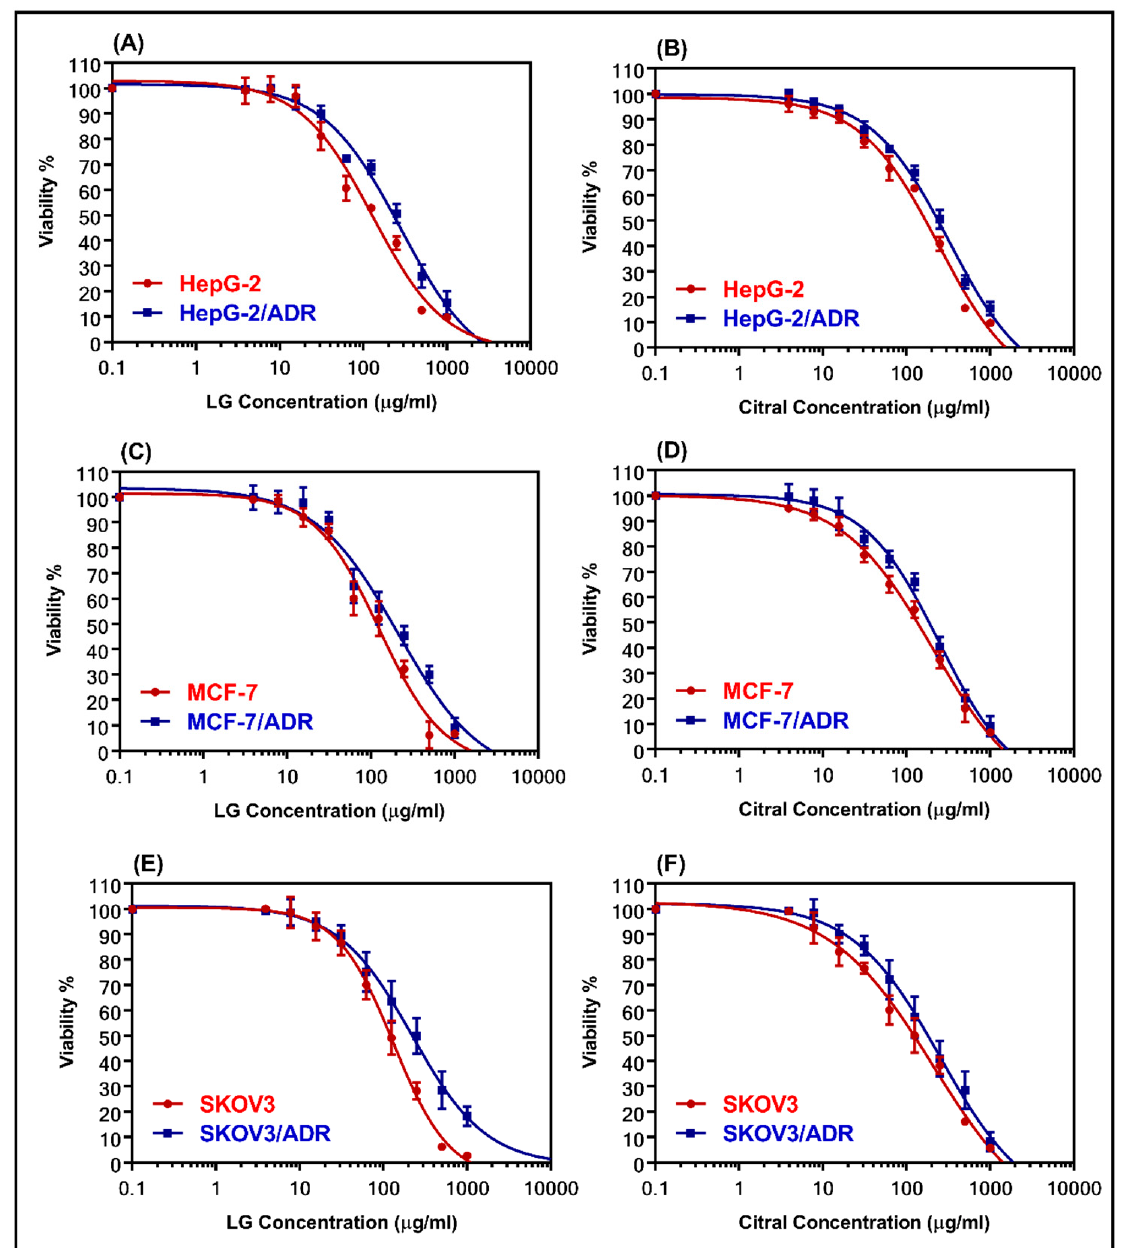
Figure 2. The dose-response curves for LG and citral were determined in sensitive and resistant hepatic ( A , B ), breast ( C , D ), and ovarian ( E , F ) cell lines, respectively. The individual cell lines were incubated for 24 h with several concentrations (0.1–1000 µg/mL) of LG essential oil and the major constituent, citral. The cell proliferation was evaluated using an MTT assay.